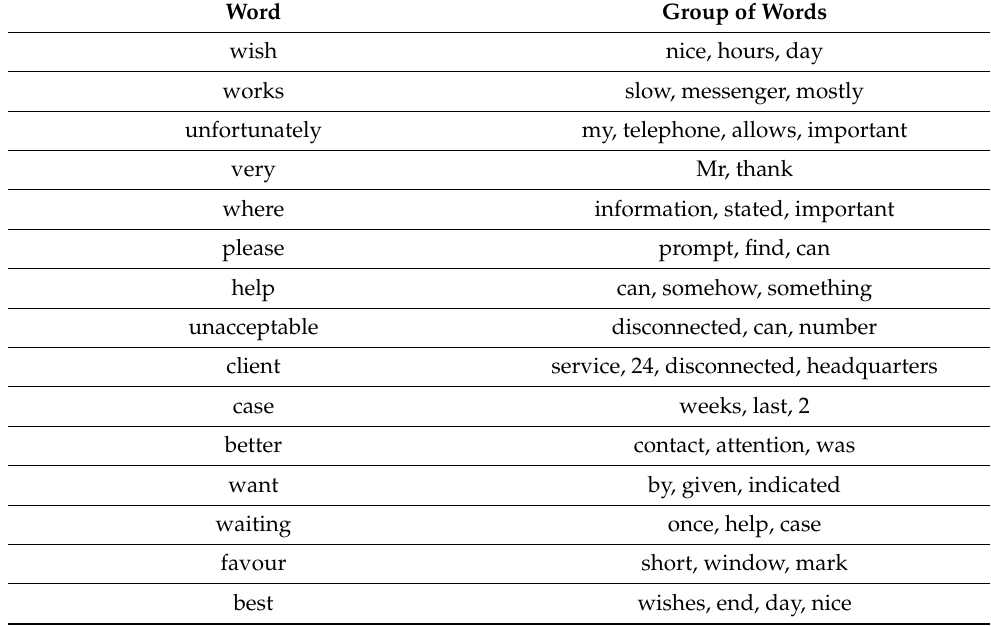
Table 7. Collocations of